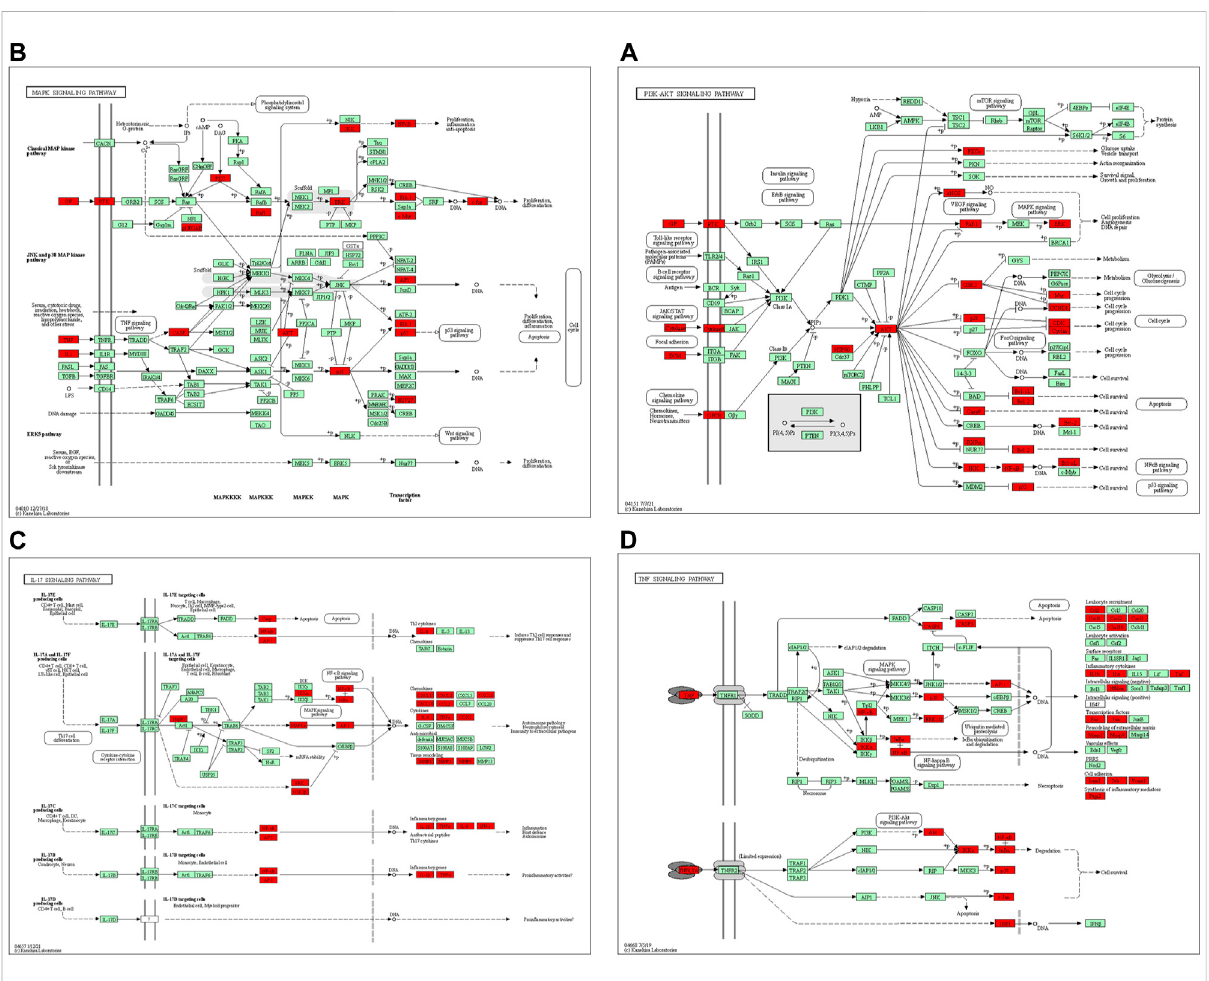
FIGURE 8 The primary pathways were colored using the KEGG mapper. Red nodes represent the targets regulated by PD in colon cancer. (A) PI3K-Akt signaling pathway. (B) MAPK signaling pathway. (C) IL-17 signaling pathway. (D) TNF signaling pathway.